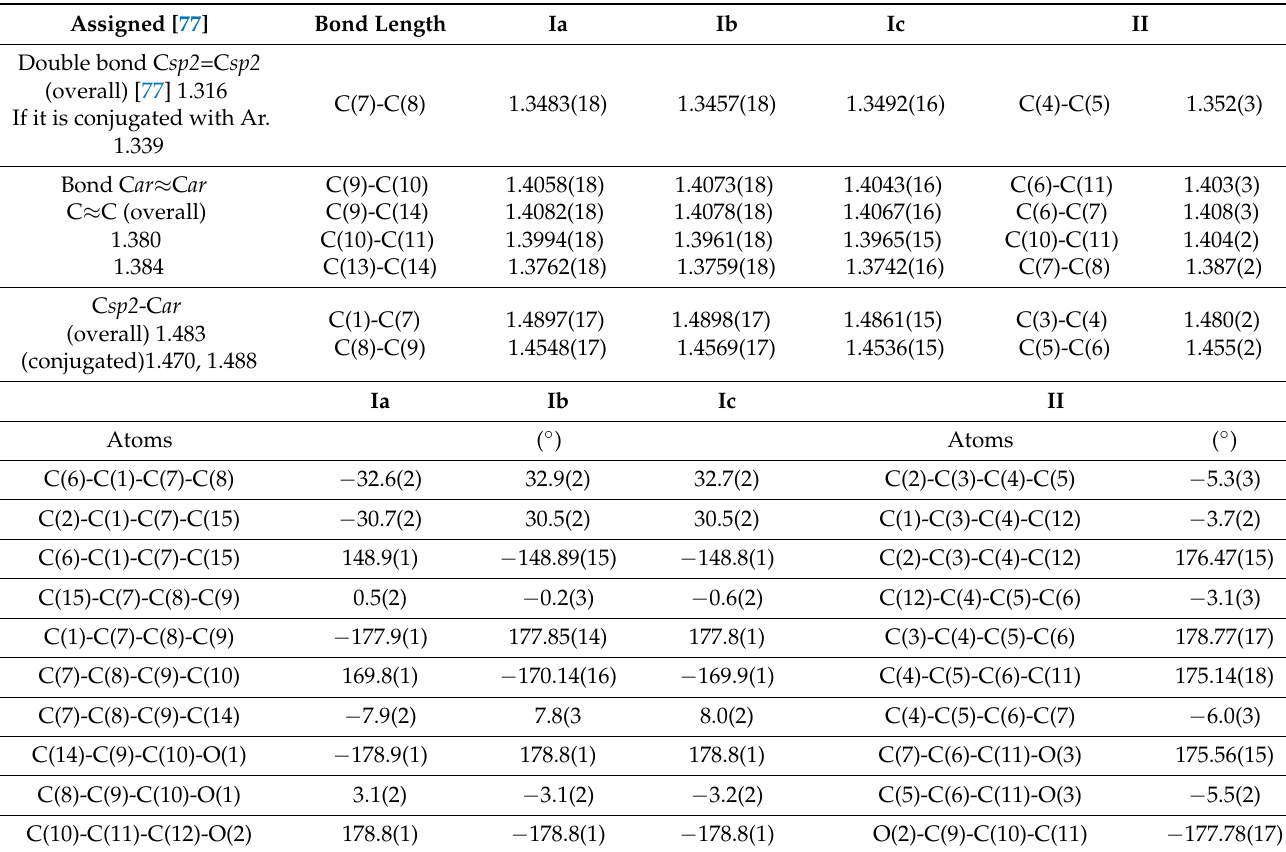
conditions and of II